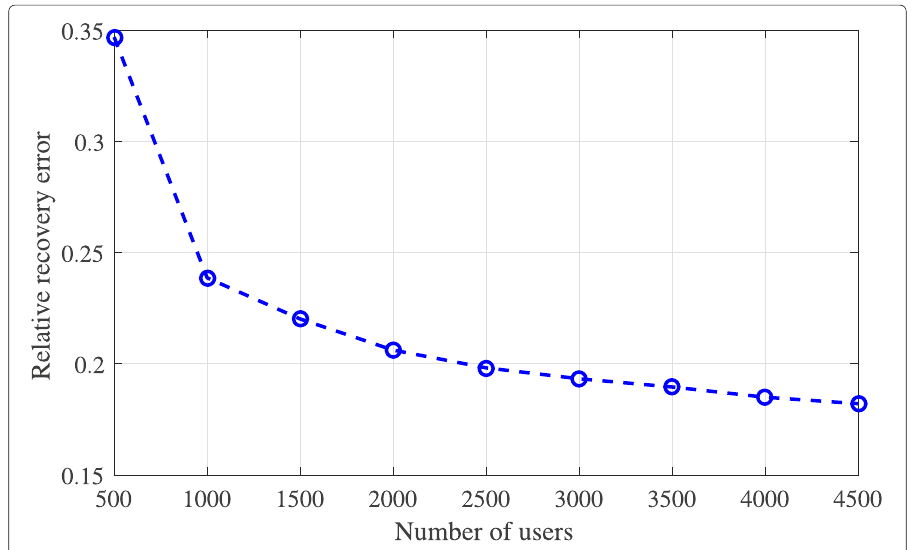
Fig. 9 Relative recovery error when the number of users